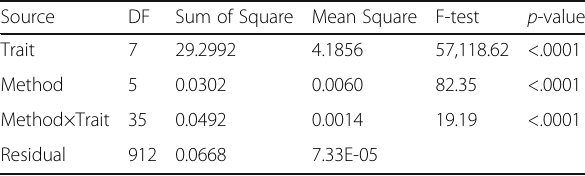
Table 2 Analyses of variances of predictabilities for eight traits and six prediction methods with 20